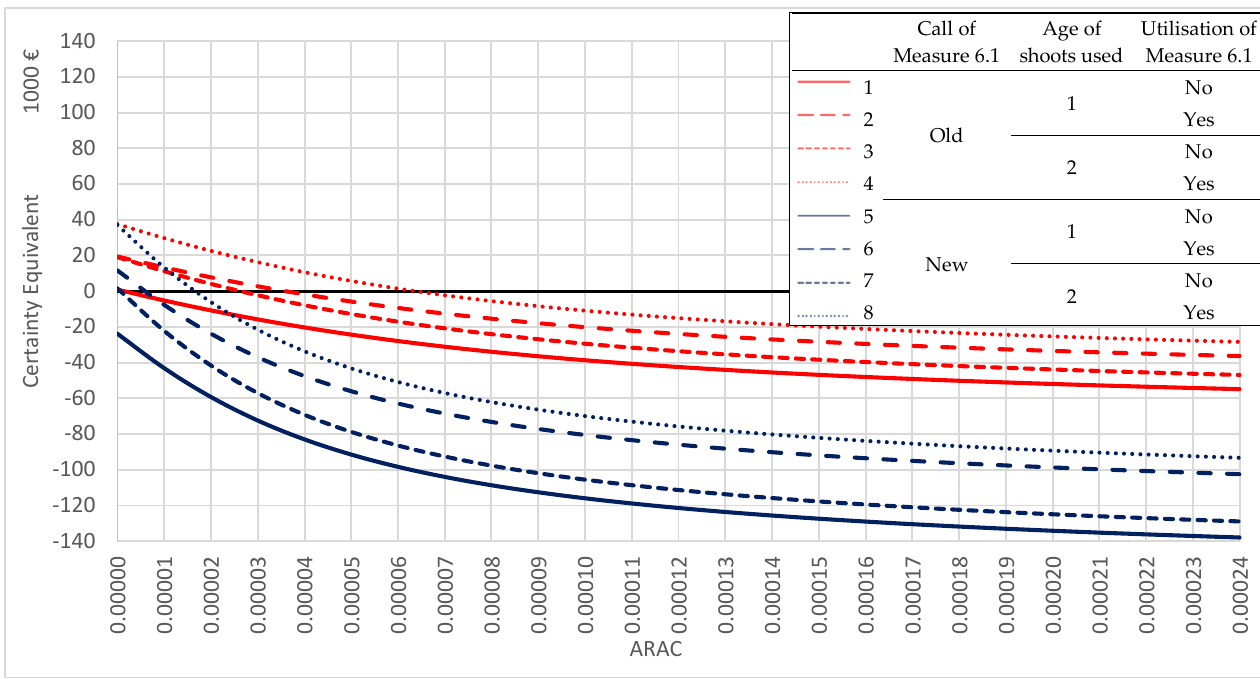
Figure 9. Stochastic Dominance with Respect to a Function (SERF) analysis results (source: own collaboration).